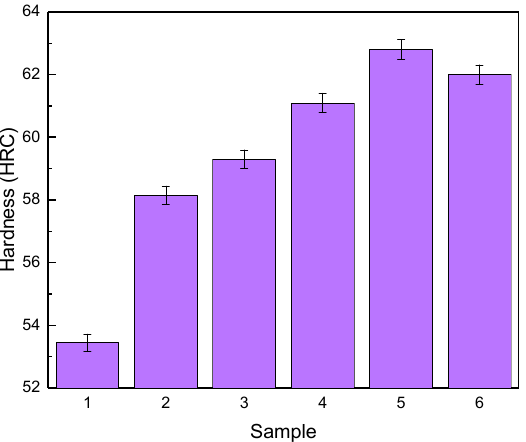
Figure 7. The results of the hardness test.